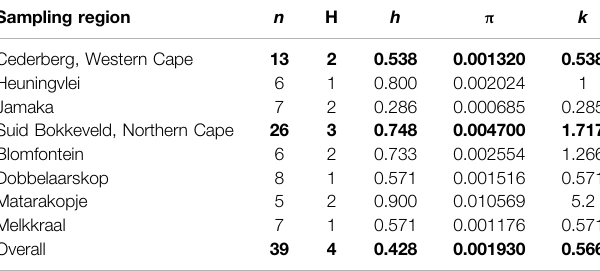
Boldtype face indicates the two regions, namely the Cederberg region of the Western Cape and the Suid Bokkeveld, Northern Cape region as well as the diversity indices across all of the